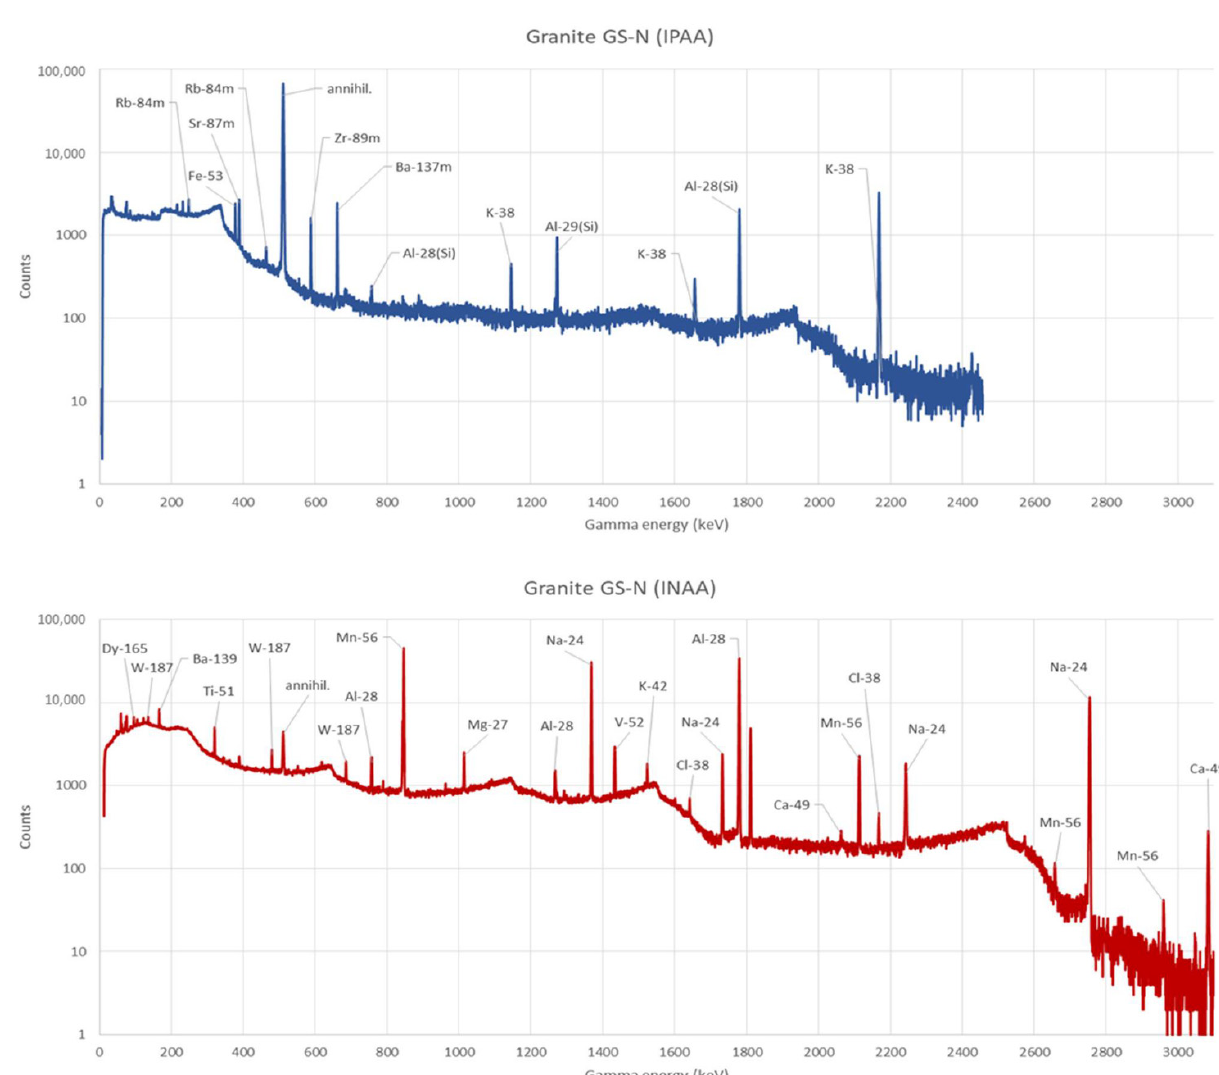
Figure 4. A typical gamma spectrum obtained in IPAA with short-time irradiation (blue spectrum) in comparison with a spectrum obtained in INAA with short-time irradiation (red spectrum) for the analysis of granite CNRS GS-N. IPAA: 2.5 g sample, irradiation at the MT-25 microtron, 19 MeV beam energy, t i - t d - t c 600-180-600 s, counting 1 cm from detector top (see Section 3.2 and Table 3). INAA: 0.05 g sample, irradiation at the LVR-15 reactor of the Research Center ˇRež, t i - t d - t c 1-13-13 min, counting 15 cm from detector